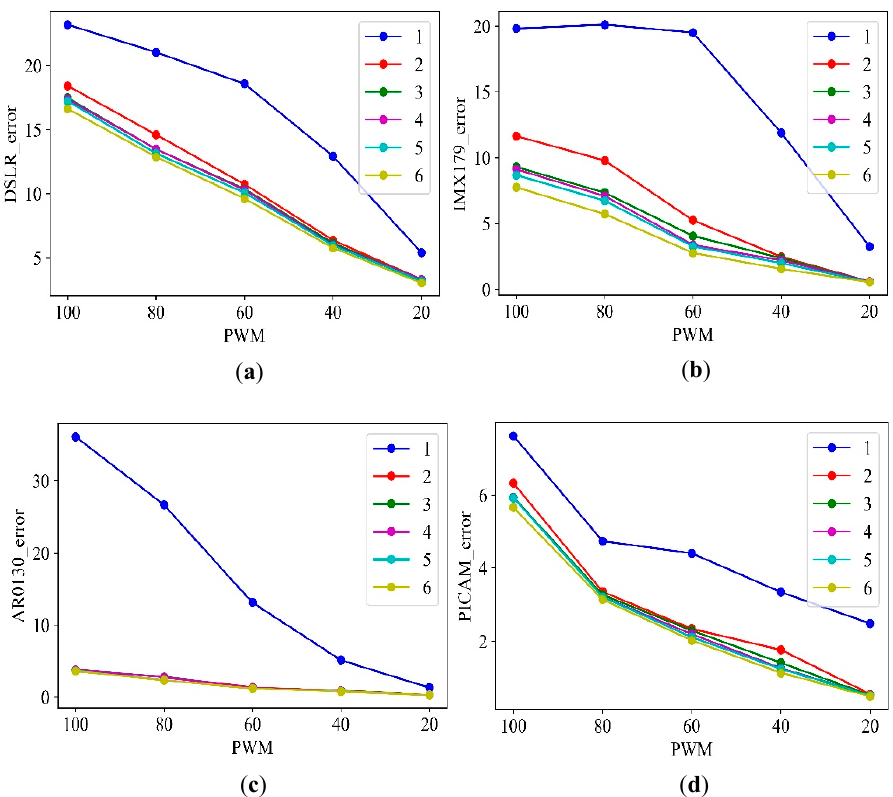
Figure 8. Errors according to PWM for each order of cameras: ( a ) DSLR; ( b ) IMX179; ( c ) AR0130; ( d ) PICAM.